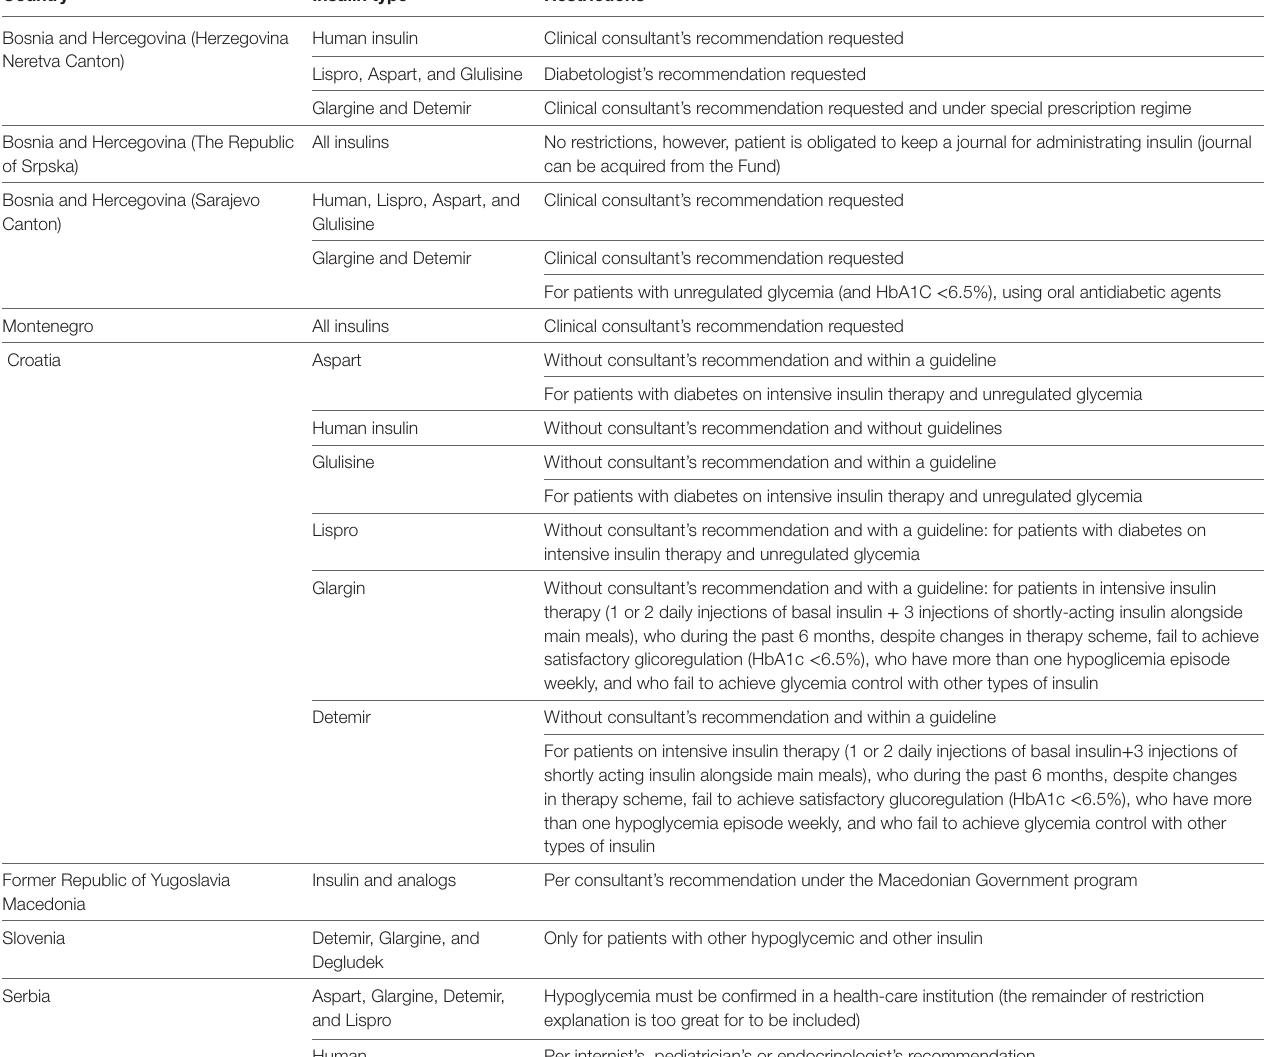
TaBle 8 | Prescribing-related restrictions for insulin in family practice.